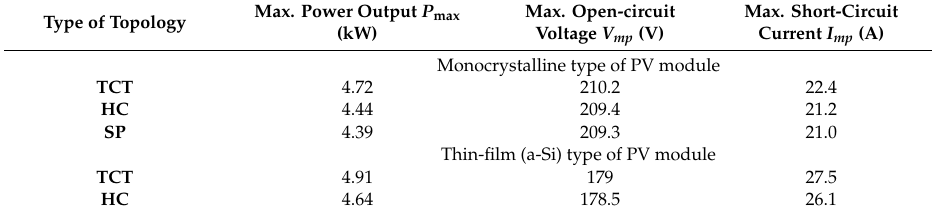
Table 6. Parameters of the PV model during open-circuit fault (F1).